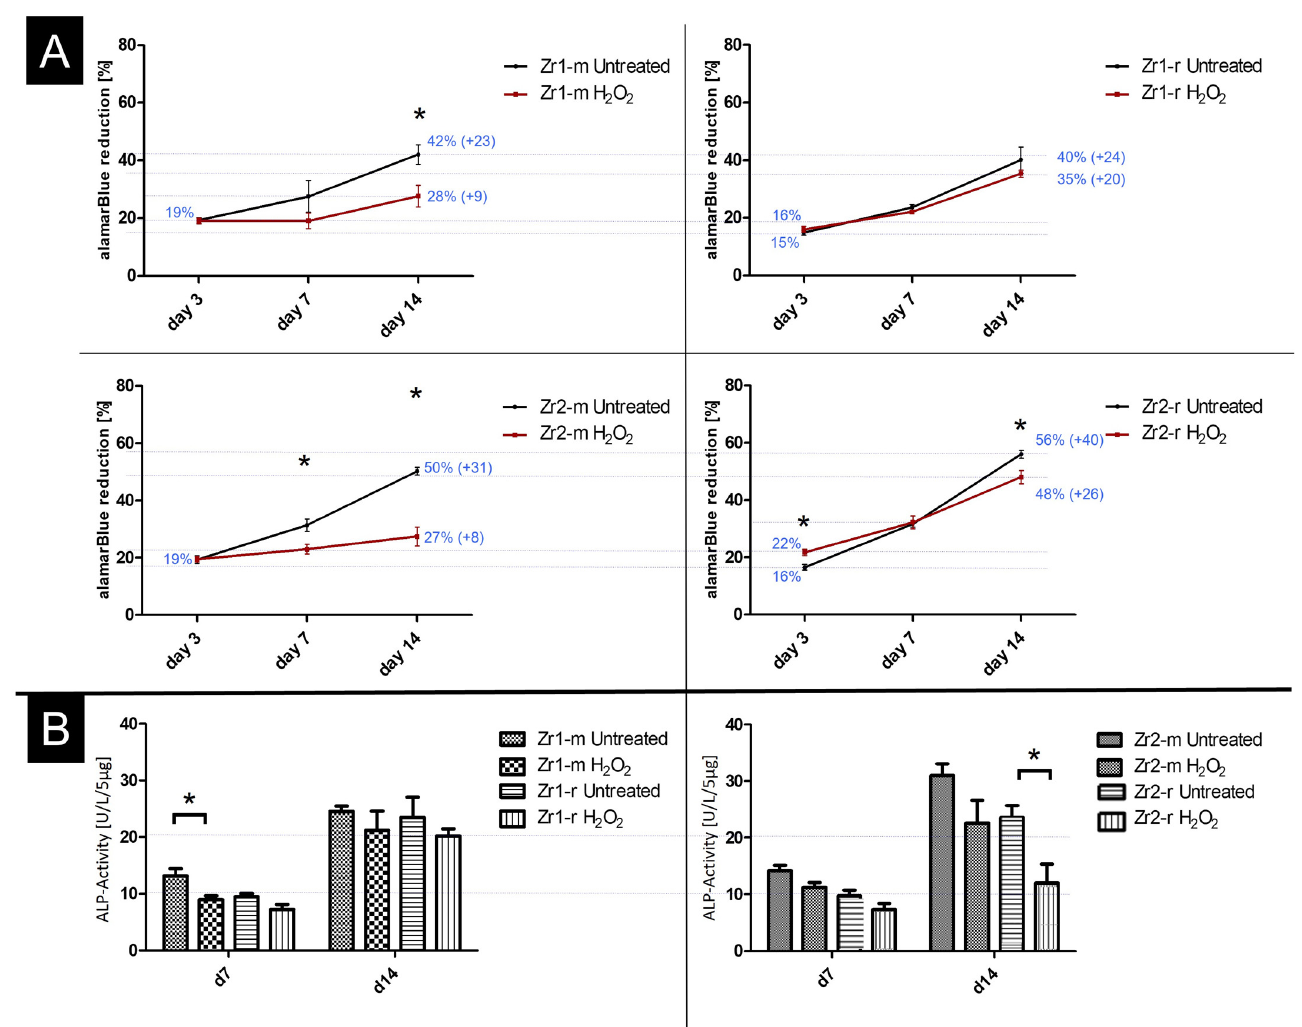
Figure 5. ( A , B ) Proliferation and differentiation activity of AO on H 2 O 2 -treated and untreated surfaces. ( A ) Cell proliferation by the alamarBlue ® metabolic assay at 3, 7 and 14 days of culture. For a clear illustration of the development of proliferation rates, the graphs are labeled with the most important percentages at days 3, 7 and 14. ( B ) Determination of differentiation capacity by measuring alkaline phosphatase activity of the normalized protein amount (5 µ g protein for each reaction) between H 2 O 2 -treated and untreated groups at days 7 and 14. The data were collected from triplicates of three independent experiments (n = 9), with a predefined constant cell number of 5 × 10 4 cells per disc. Statistical significances with p < 0.05 are labeled with “*” in the graphs. The increase in AB reduction from day 3 to day 14 on smooth surfaces was thereby +23% for Zr1-m vs. +9% for Zr1-m+H 2 O 2 , and +31% for Zr2-m vs. +8% for Zr2-m+H 2 O